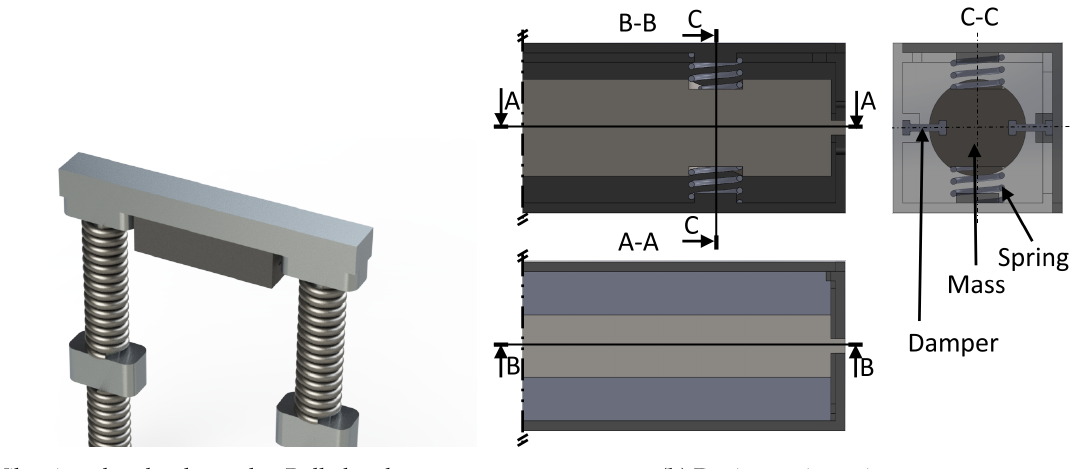
Figure 12. Dynamic vibration absorber